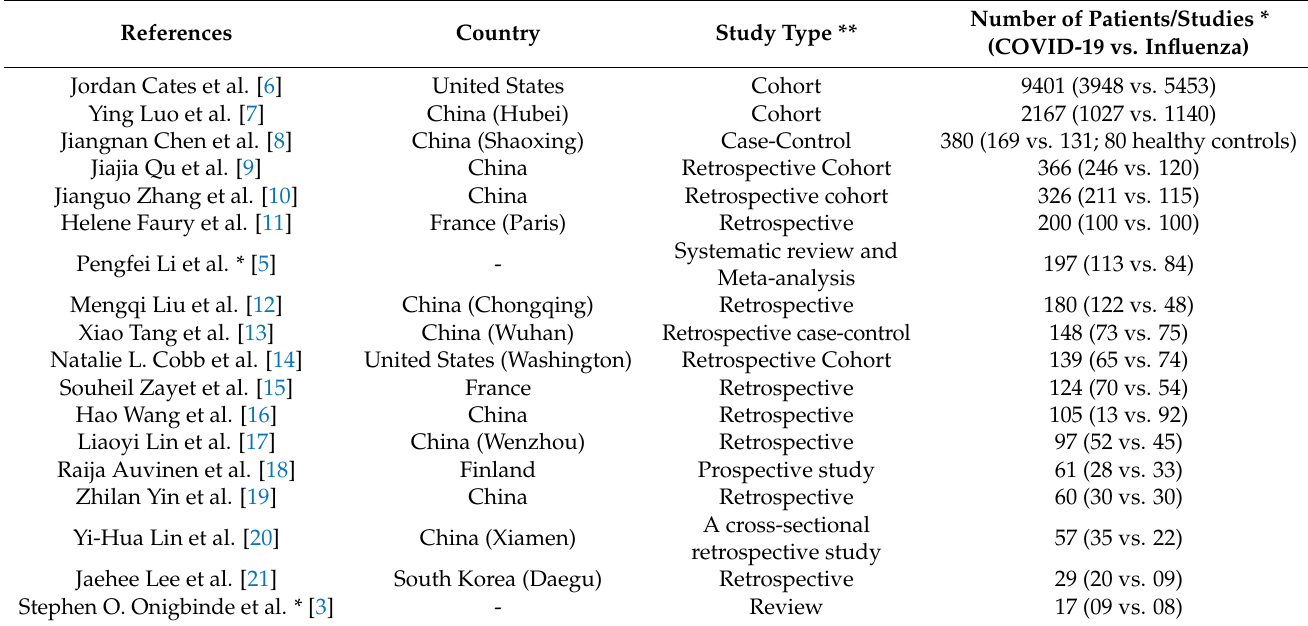
Table 1. General summary of included